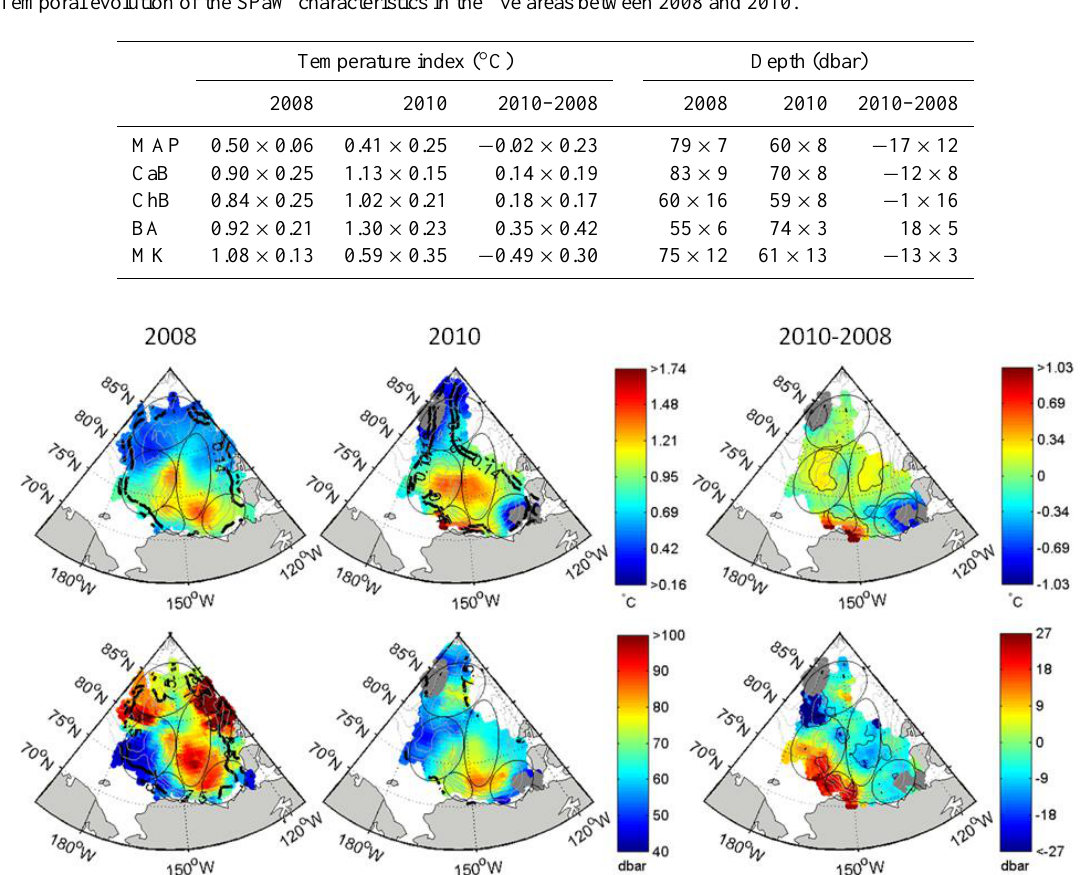
Table 3. Temporal evolution of the SPaW characteristics in the five areas between 2008 and 2010.